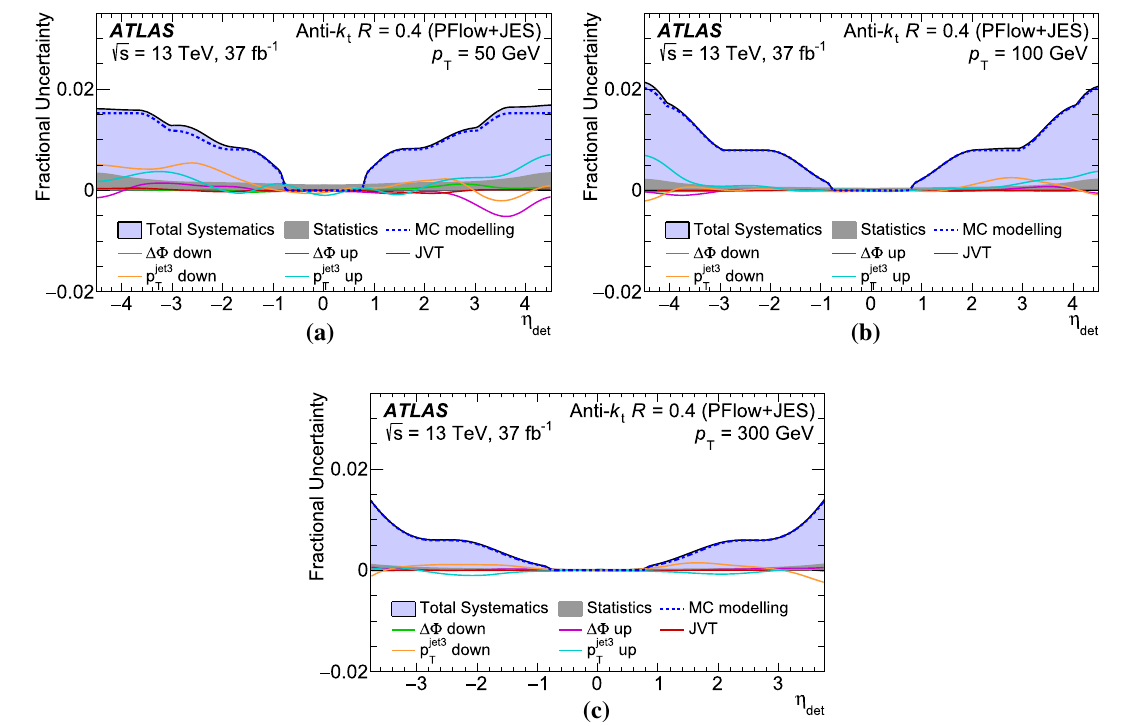
Fig. 10 Systematic uncertainties associated with the η intercalibration procedure as a function of η det for PFlow+JES jets of a p T = 50 GeV, b p T = 100 GeV, and c p T = 300 GeV. The solid purple band shows the total systematic uncertainty, while the grey band shows the statisti-